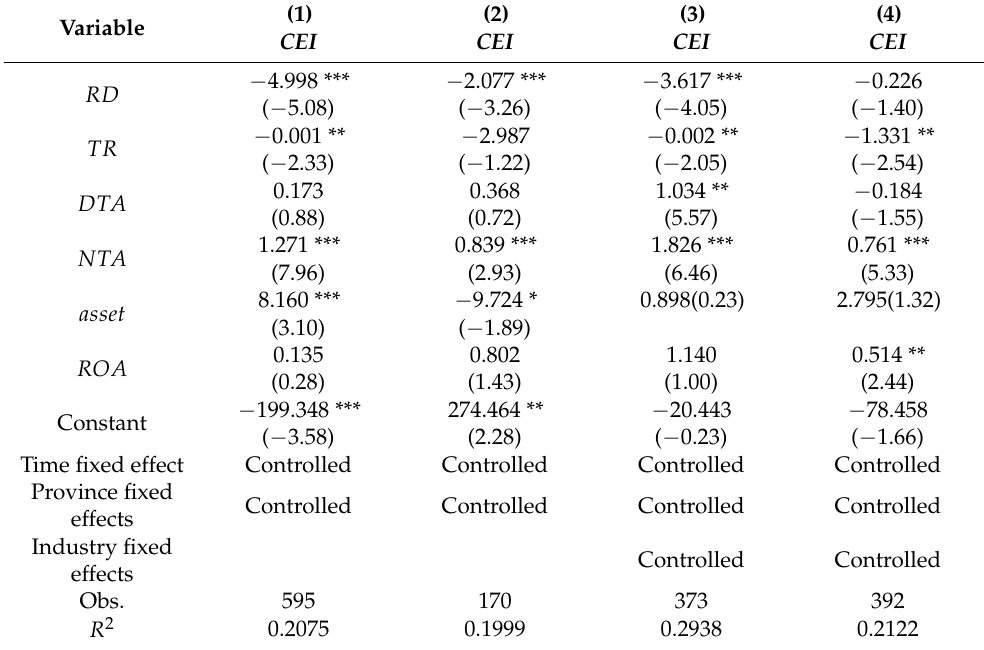
Table 8. Subsample regression